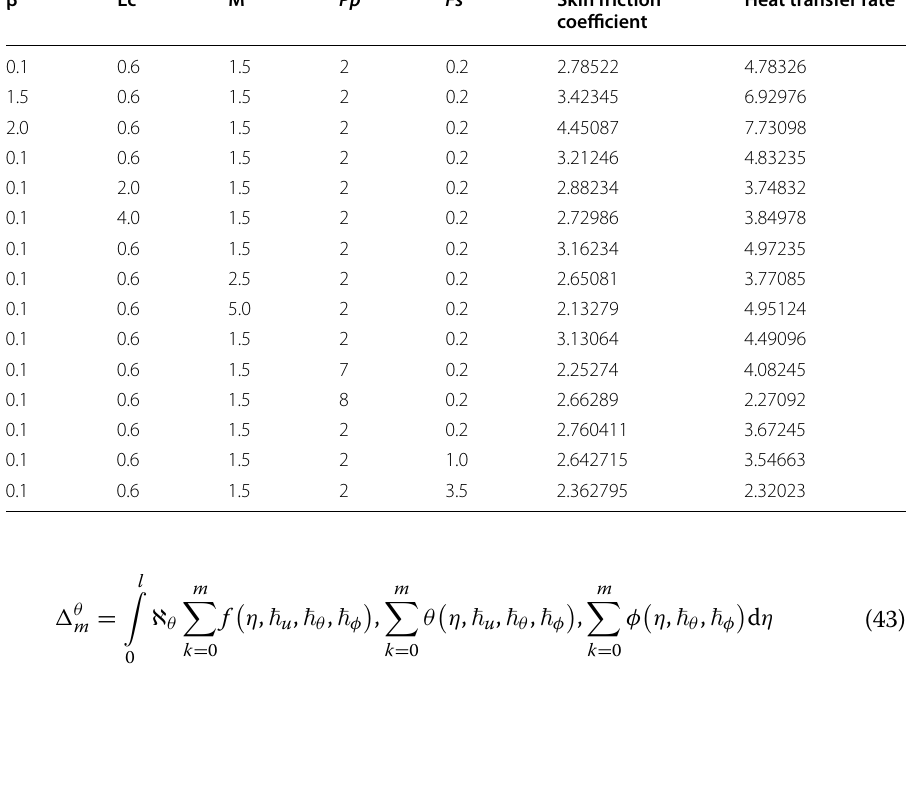
Table 6 Skin friction coefficient and rate of heat transfer for (Prandtl-number β